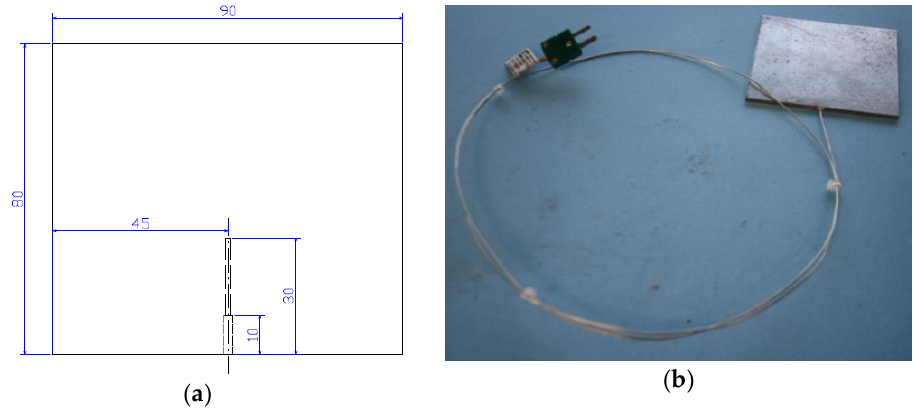
Figure 2. ( a ) Test sample sketch; ( b ) samples with the K thermocouple inserted.